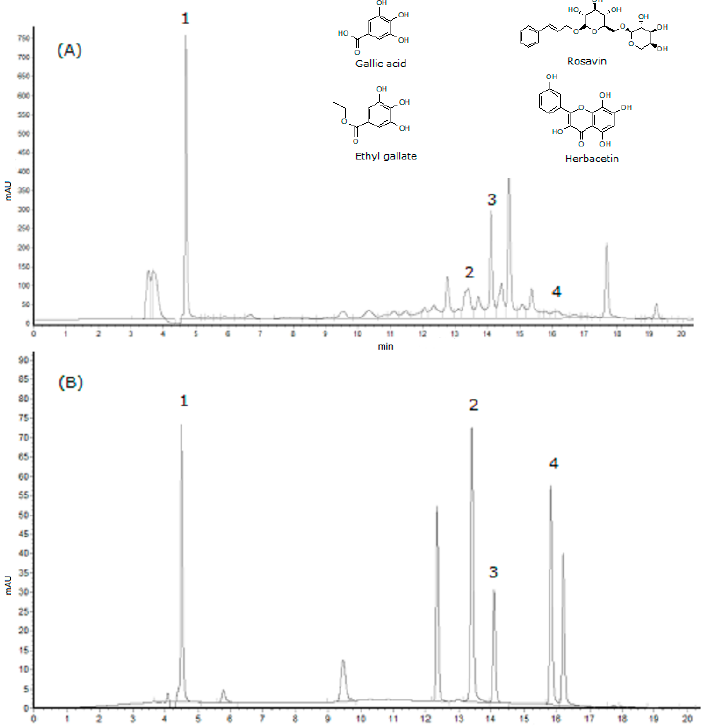
Figure 2. The HPLC chromatograms of ethyl acetate extract ( A ) and the standard references ( B ) at 275 nm; 1—gallic acid; 2—ethyl gallate; 3—rosavin, and 4—herbacetin.